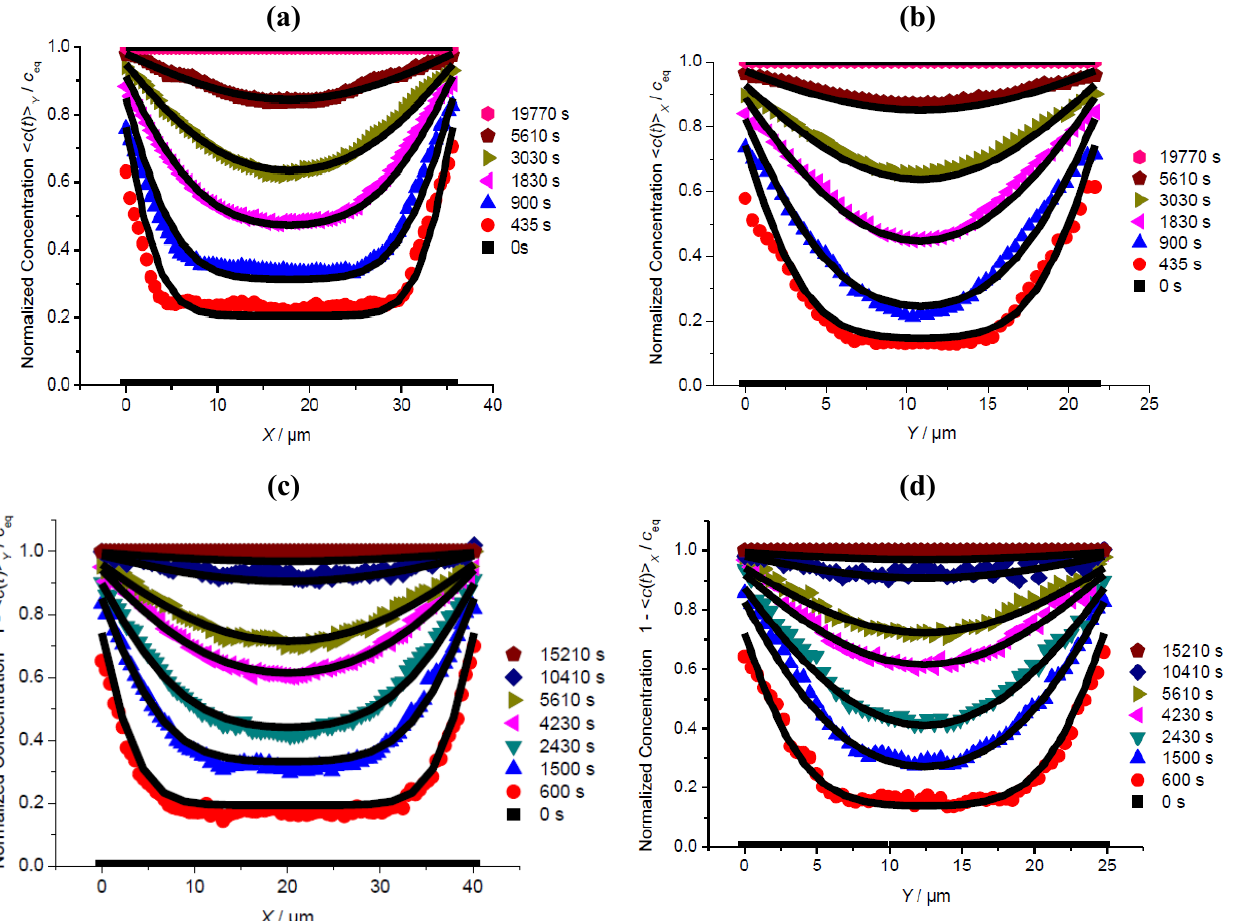
Figure 5. Profiles of mean concentrations during uptake ( a , b ) and release ( c , d ) of